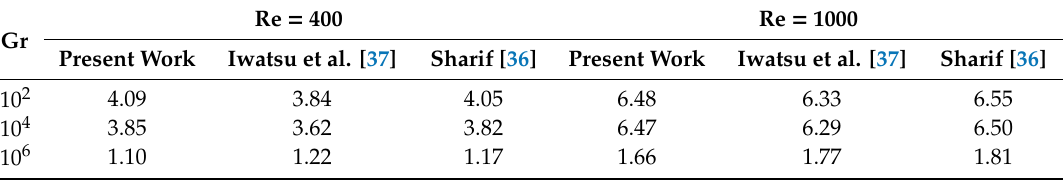
Table 2. Comparison of average Nusselt numbers for mixed convection in a lid-driven